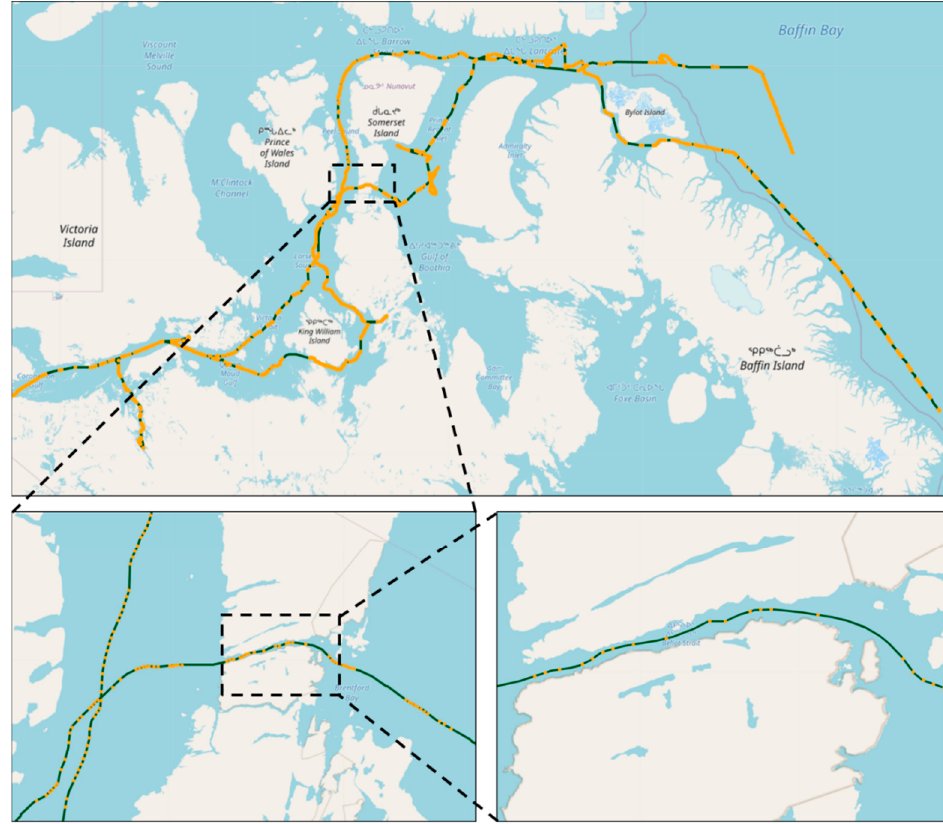
Figure 13. Trajectory reconstruction results with MMSI of 316025029.